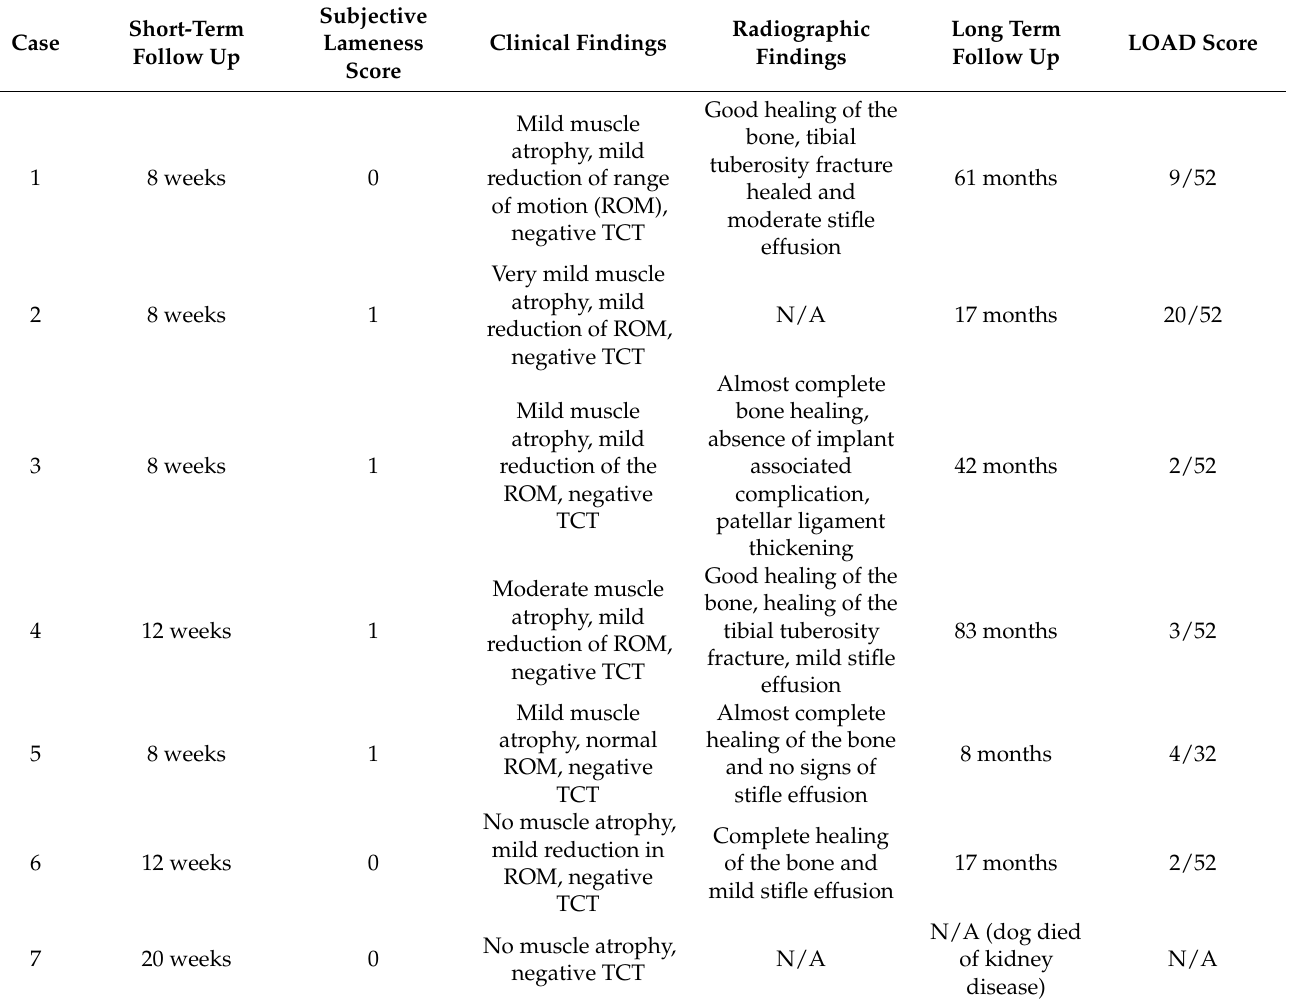
Table 3. Clinical, radiographic findings and LOAD questionnaire